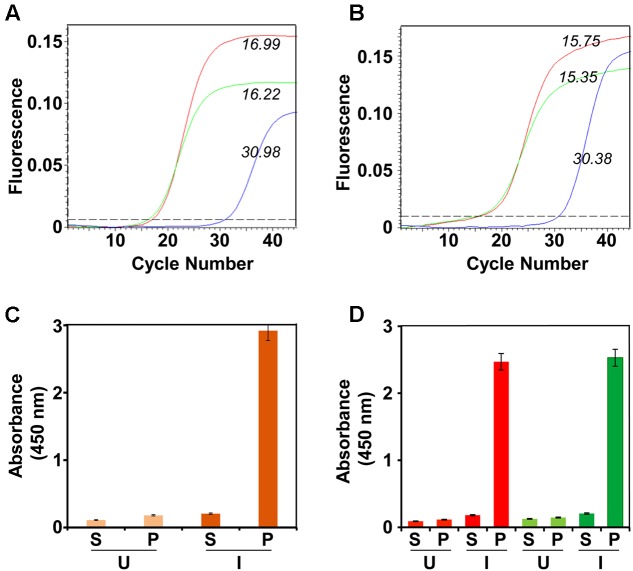
Expression and localization of DENV E1E2bv. (A) Real time analysis of DENV E1 and E2 mRNA expression in Pichia pastoris transformed with pDENV-E1E2bv. Total RNA was isolated from the methanol-induced bivalent clone of P. pastoris, transcribed to cDNA using reverse primers specific to either E1 (red) or E2 (green) and subjected to qPCR. Total RNA from P. pastoris transformed with the empty expression vector pAO815 was subjected to RT-qPCR in parallel as a negative control (blue). (B) RT-qPCR amplification profiles obtained using total RNA extracted from un-transformed P. pastoris host (blue) or monovalent P. pastoris clones expressing E1 (red) or E2 (green). In (A,B), the italicized Arabic numerals indicate Ct values. (C) Localization of E1E2bv expression. The bivalent P. pastoris clone (orange bars) lysed either before (U) or after (I) methanol induction and separated into the supernatant (S) and pellet (P) fractions was analyzed by His-Sorb ELISA using a dengue specific mAb 24A12. (D) Similar experiment, as in ‘C,’ performed in parallel with monovalent P. pastoris clones expressing E1 (red bars) or E2 (green bars) proteins.